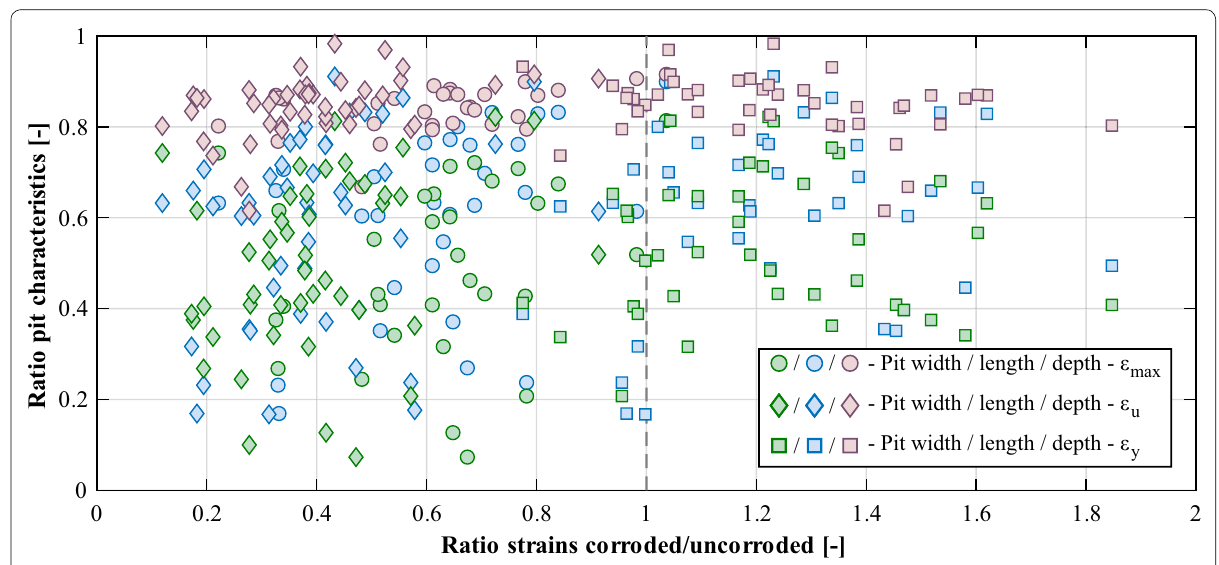
Fig. 18 Normalised pit characteristics as function of normalised